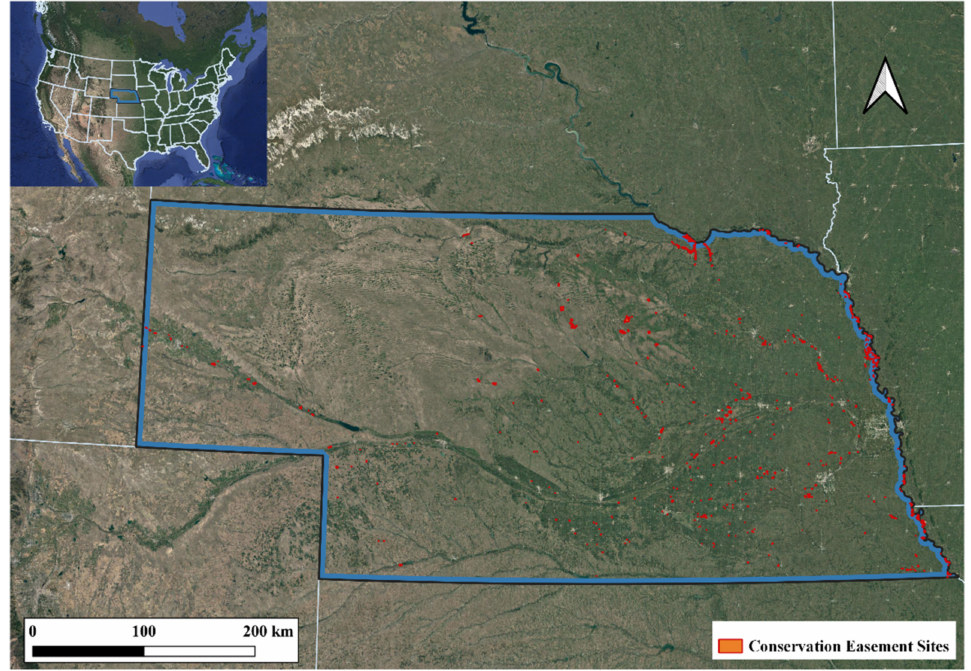
Figure 1. Location map of CE sites in